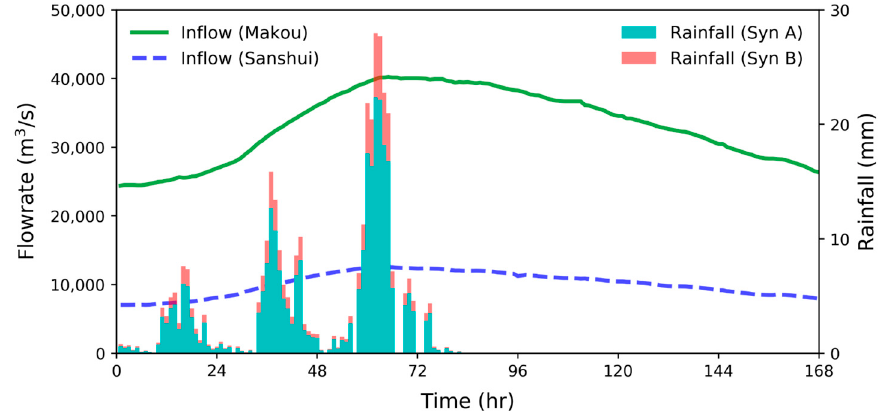
Figure 9. Design river inflows at the source stations (Makou and Sanshui) and the average hourly rainfall from 25 gage stations in the study area for Syn A and B events.